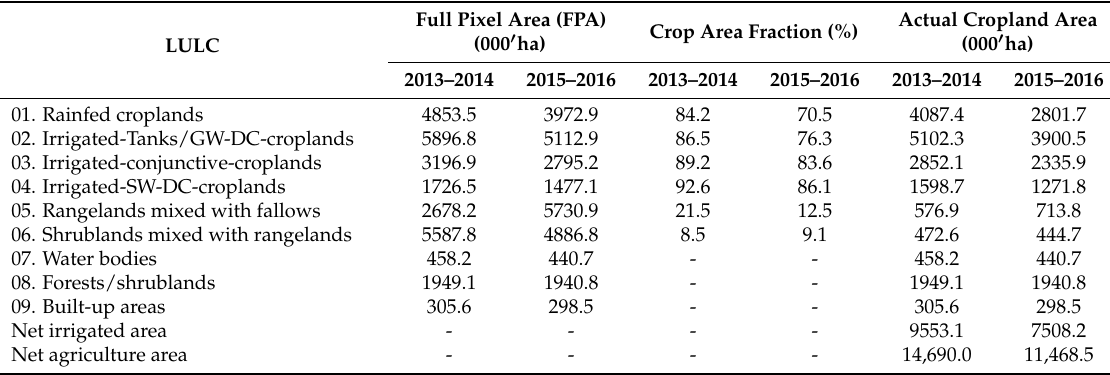
Figure 4. Spatial distribution of land use/land cover (LULC) (derived from 2013–2014 MODIS composite). (Note: GW = groundwater; SW = surface water; DC = double crop). Table 2. Irrigated, rainfed, and other LULC